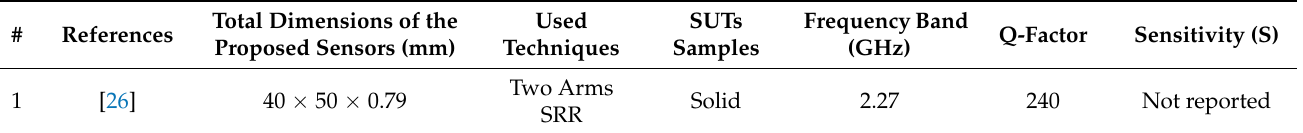
Table 1. Detailed comparison of state-of-the-art technology of curve-feed CSRR sensor for material detections with the existing